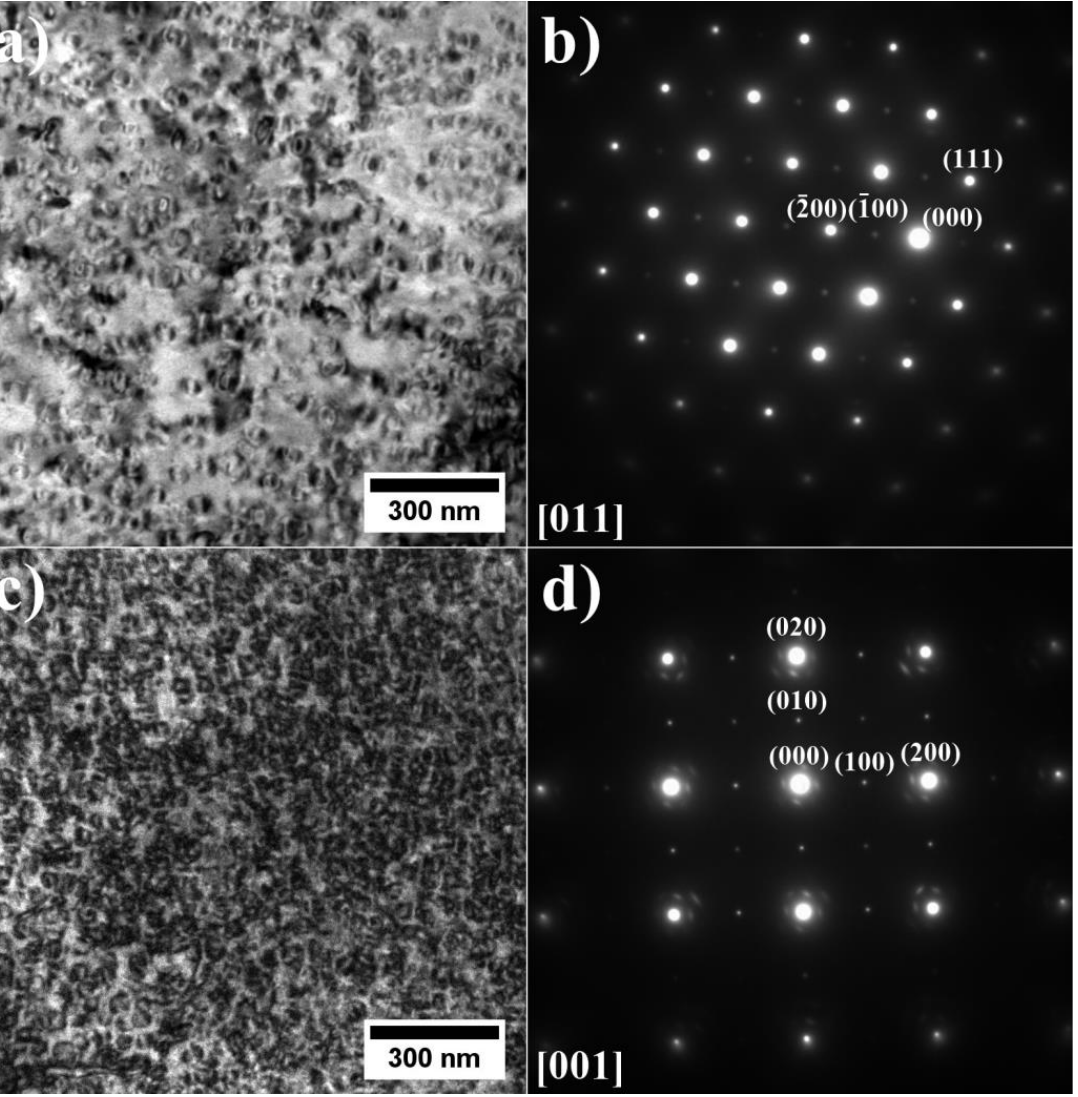
Figure 6. Morphology of the γ’ precipitates in the dendritic region and corresponding SAED patterns: ( a , b ) A3; ( c , d ) A6, TEM-BF.